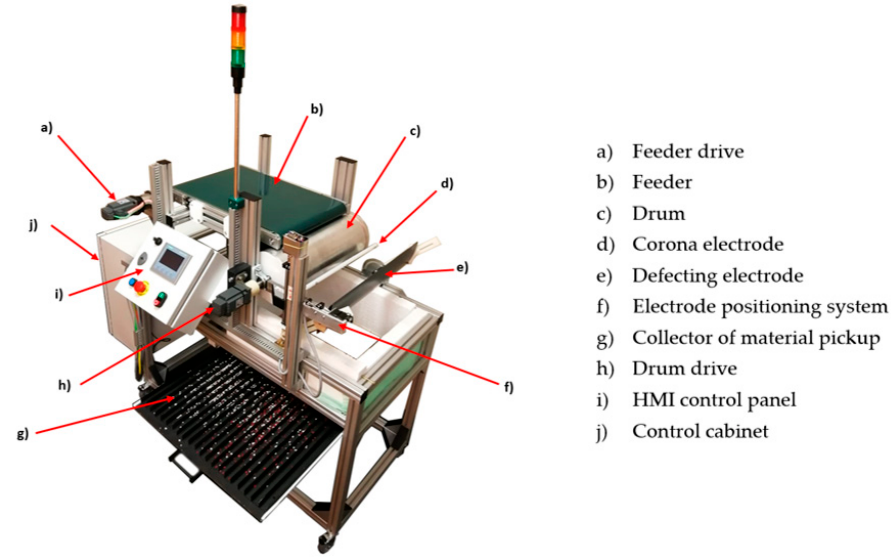
Figure 10. Prototype electrostatic separator.